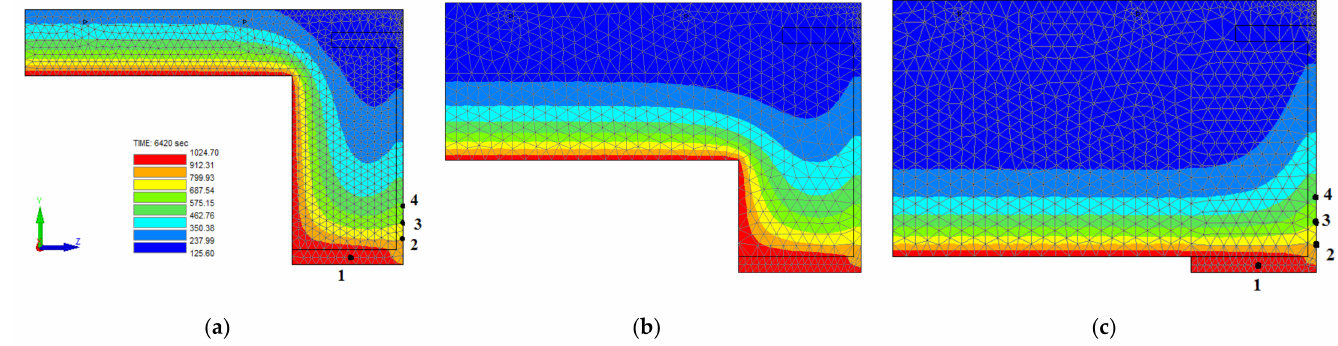
Figure 6. Cross-sections of the WFRC 66162 test: ( a ) cross-section F with a thinner concrete slab depth [28]; ( b ) transition cross-section; ( c ) cross-section G with a concrete slab standing on the lower flange of the steel profile